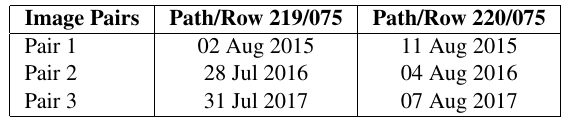
Table 1: Acquisition dates for OLI images on Path/Row 223/072 and 222/072 to test the proposed gap-filling approach and Maxwell 2007 method